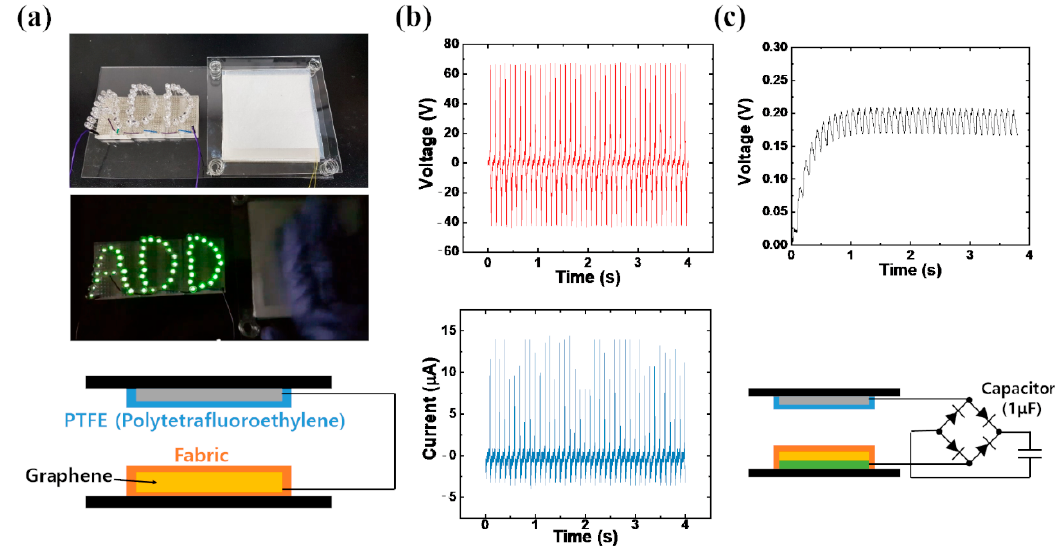
Figure 6. Graphene e-fabric based triboelectric nanogenerator, ( a ) fabrication of TENG, ( b ) open-circuit voltage and closed- circuit current generated at a vertical input frequency of 10 Hz, and ( c ) 1 μ F capacitor charged by TENG (circuit illustrated).